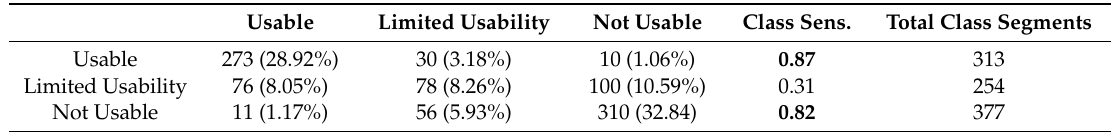
Table 7. Confusion matrix for corrSQI quality indicator used to classify the non-contact ECG segments in to usable, limited usability and not usable. Usable Limited Usability Not Usable Class Sens. Total Class Segments Usable 273 (28.92%) 30 (3.18%) 10 (1.06%) 0.87 313 Limited